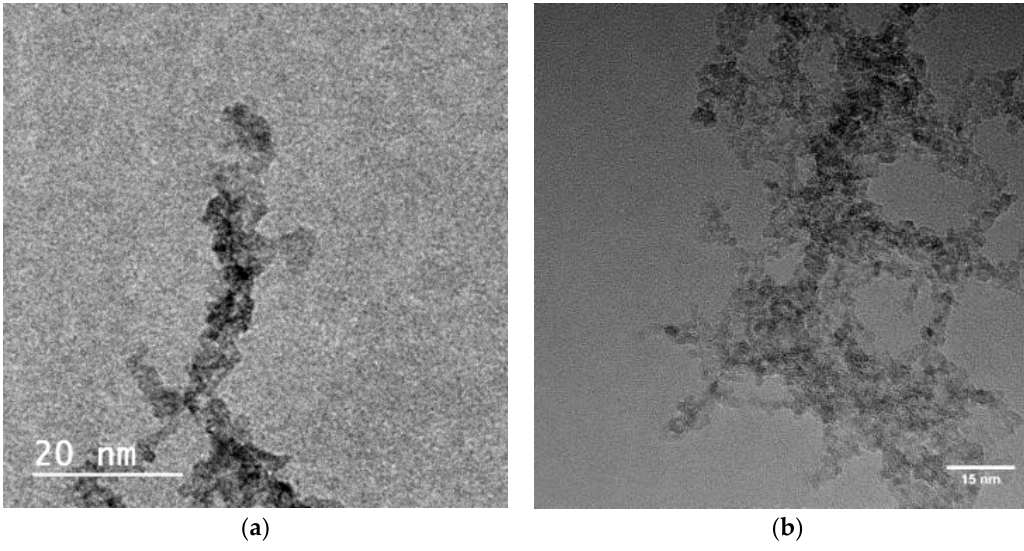
Figure 4. NiO NPs being image on: ( a ) 5 nm Al 2 O 3 , 120 keV TEM; ( b ) 15 nm SiN ETW, 200 keV TEM. ( a ) has a much brighter background indicating that the electron beam is minimally scattered compared to ( b